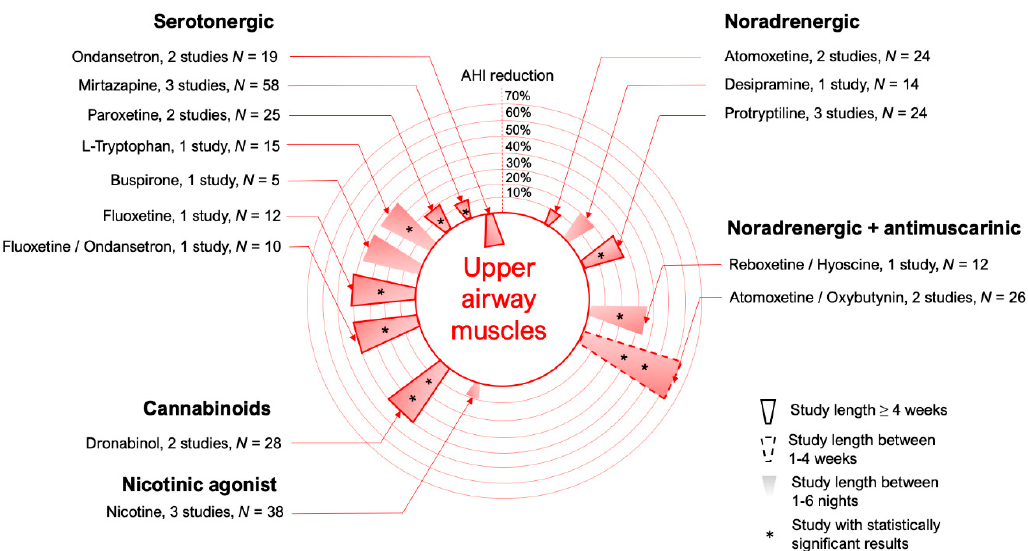
Figure 3. Circular bar plot describing the studies performed using medications that modify upper airway muscle activity.